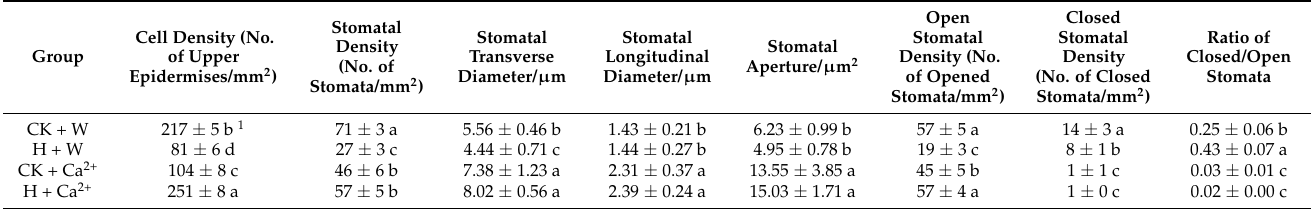
Table 2. Ultrastructure of leaf epidermal cells of Rhododendron × pulchrum leaves under the four treatments.